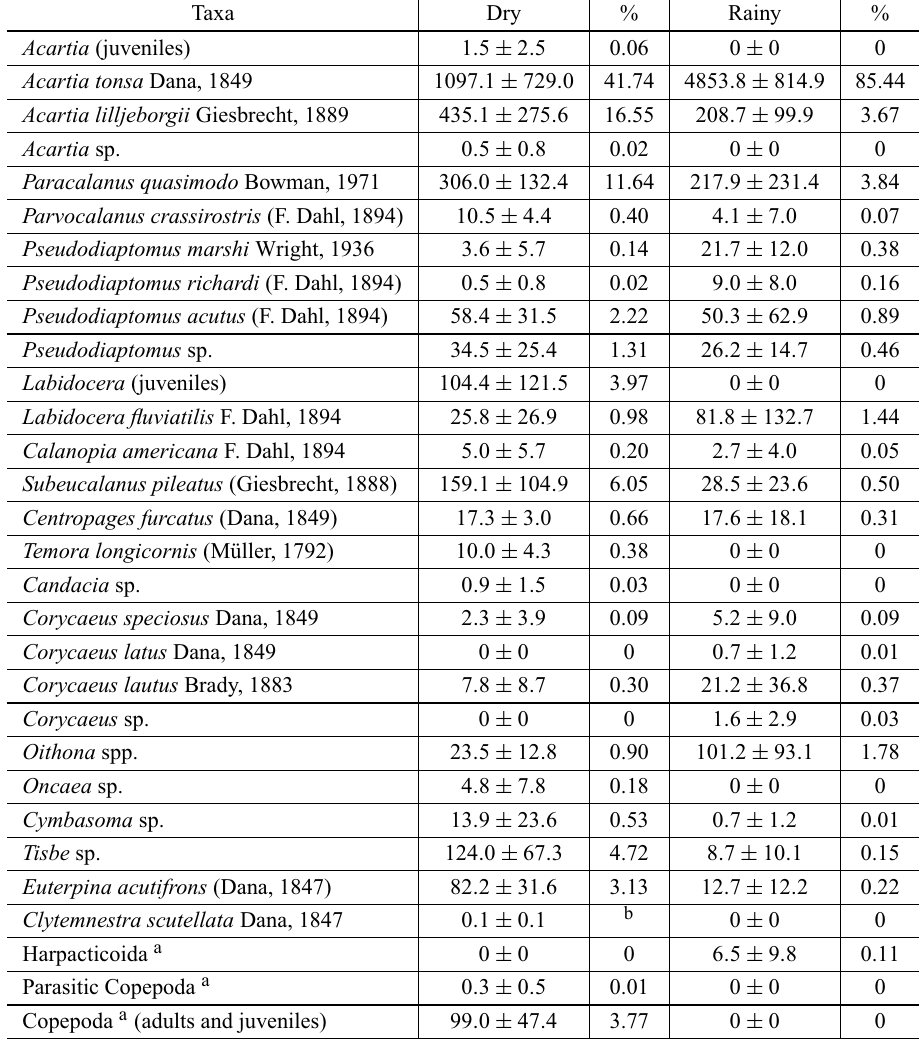
Taxonomic composition, absolute (means ± SD) and relative densities of copepods collected during dry (July, September and November) and rainy seasons (January, March and May) in the Curuçá